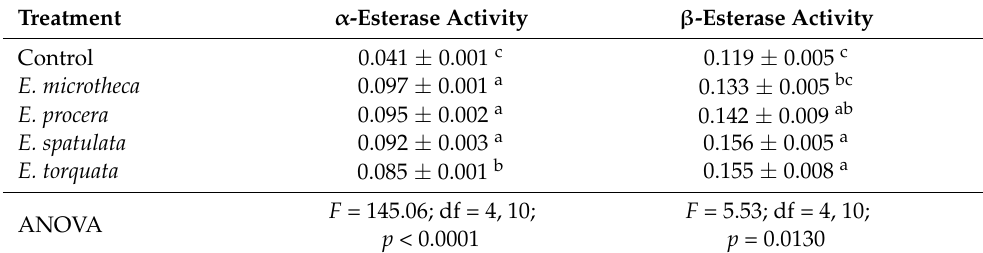
Table 5. The effects of low-lethal exposure to Eucalyptus essential oils (LC 30 concentration) on esterase